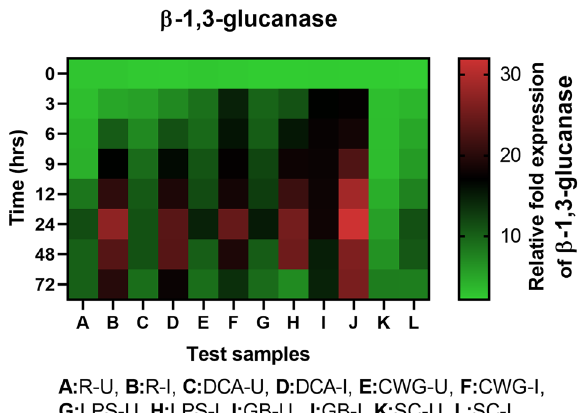
Figure 10. qRT-PCR determined relative expression of β-1,3-glucanase genes in 2-day-old P. glaucum seedlings with (I) or without (U) Sclerospora graminicola inoculation harvested 0, 3, 6, 9, 12, 24, 48, and 72 h. R—resistant, S—susceptible, DCA—3,5-Dichloroanthranilic acid treated, CWG—Cell Wall Glucans isolated from the endophyte Trichoderma hamatum UOM 13, LPS—Lipopolysaccharides isolated from bacteria Pseudomonas fluorescens UOM 14, GB—Glycinebetaine an amino acid derivative. Expression levels were measured by qPCR and normalized to the constitutive PP2A gene. Values are means of experiments carried out in four replicates The bars indicate ± SE and the data were analyzed by one-way ANOVA followed by Tukey’s test and p ≤